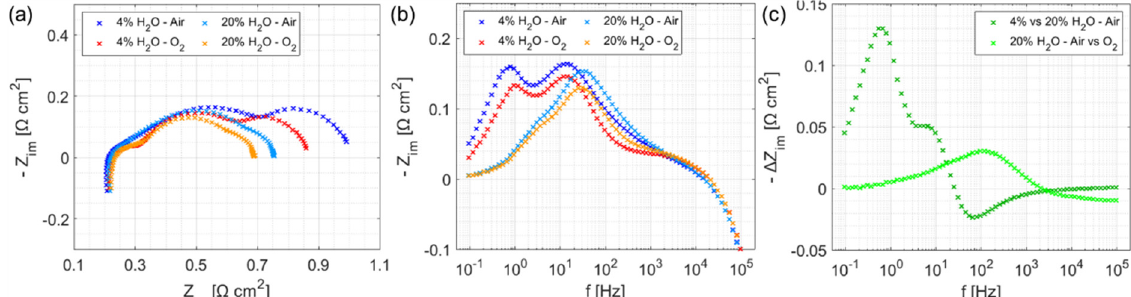
Figure 3. EIS of the ceramic SoA cell ( a ) Nyquist plot, ( b ) Bode plot, and at 650 °C, 20% and 4% H 2 O/H 2 to the fuel electrode vs. O 2 and air to the oxygen electrode, and ( c ) Delta (difference) Bode plot, 20% vs. 4% fuel humidity to the fuel electrode and air vs. O 2 to the oxygen electrode.